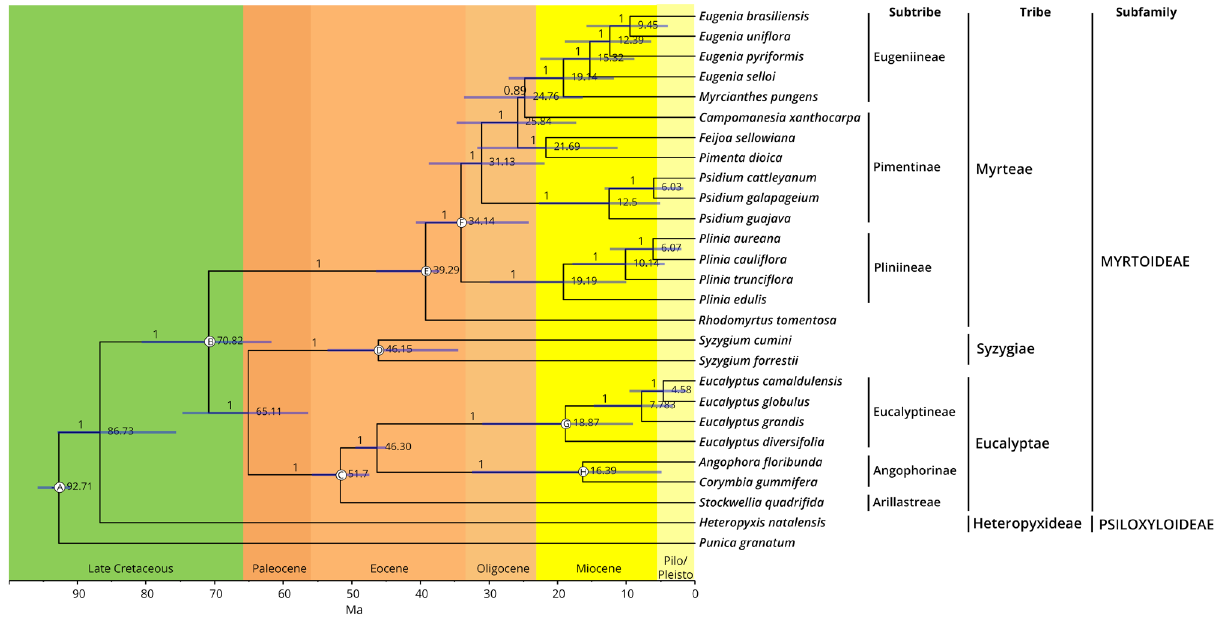
Figure 4 – Chronogram of Myrtaceae species based on a supermatrix of 78 plastid genes. Posterior probabilities for each node are indicated and nodal ages represent the median posterior estimates. Branch lengths are scaled according to time and blue bars represent the 95% highest posterior density interval of age estimates. Subtribal, tribal and subfamilial classifications of Myrtaceae species are indicated on the right. Calibrated nodes are labelled from A-H corresponding to fossil calibration detailed in Table